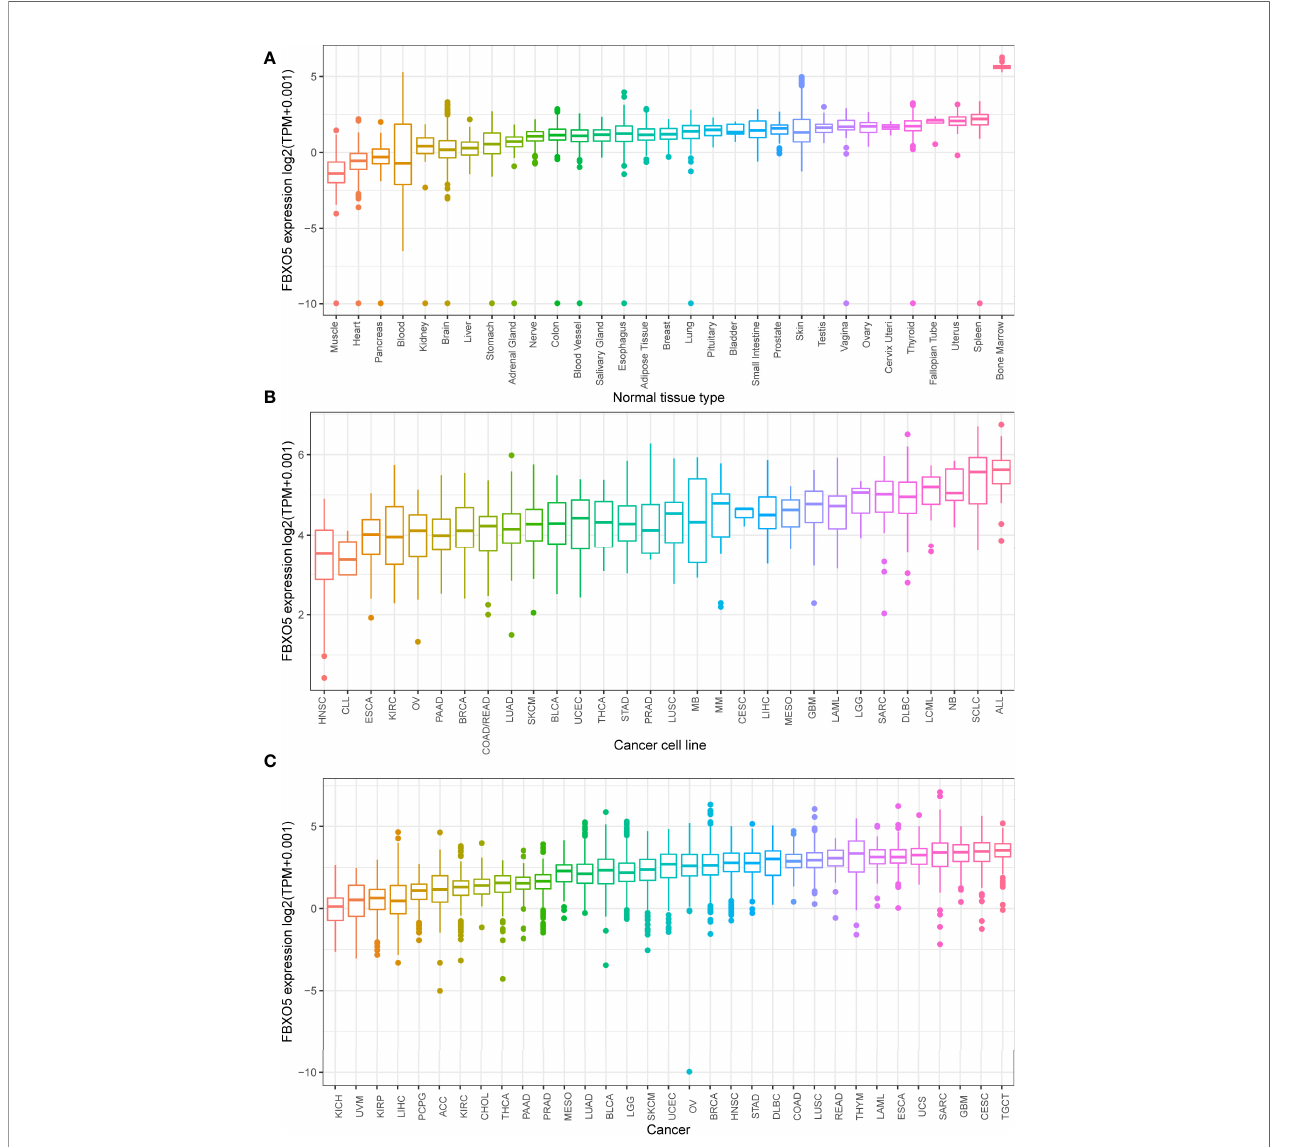
FIGURE 2 | Comparison of FBXO5 expression levels in pan-cancer. (A) FBXO5 expression pattern in 31 forms of normal samples from GTEx database. (B) FBXO5 expression pattern in 30 kinds of tumor cell lines from CCLE database. (C) FBXO5 expression pro fi le in 33 types of cancers from TCGA